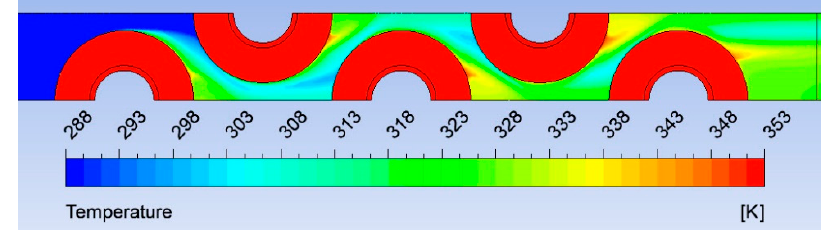
Figure 10. Temperature contours of ideal annular fins.